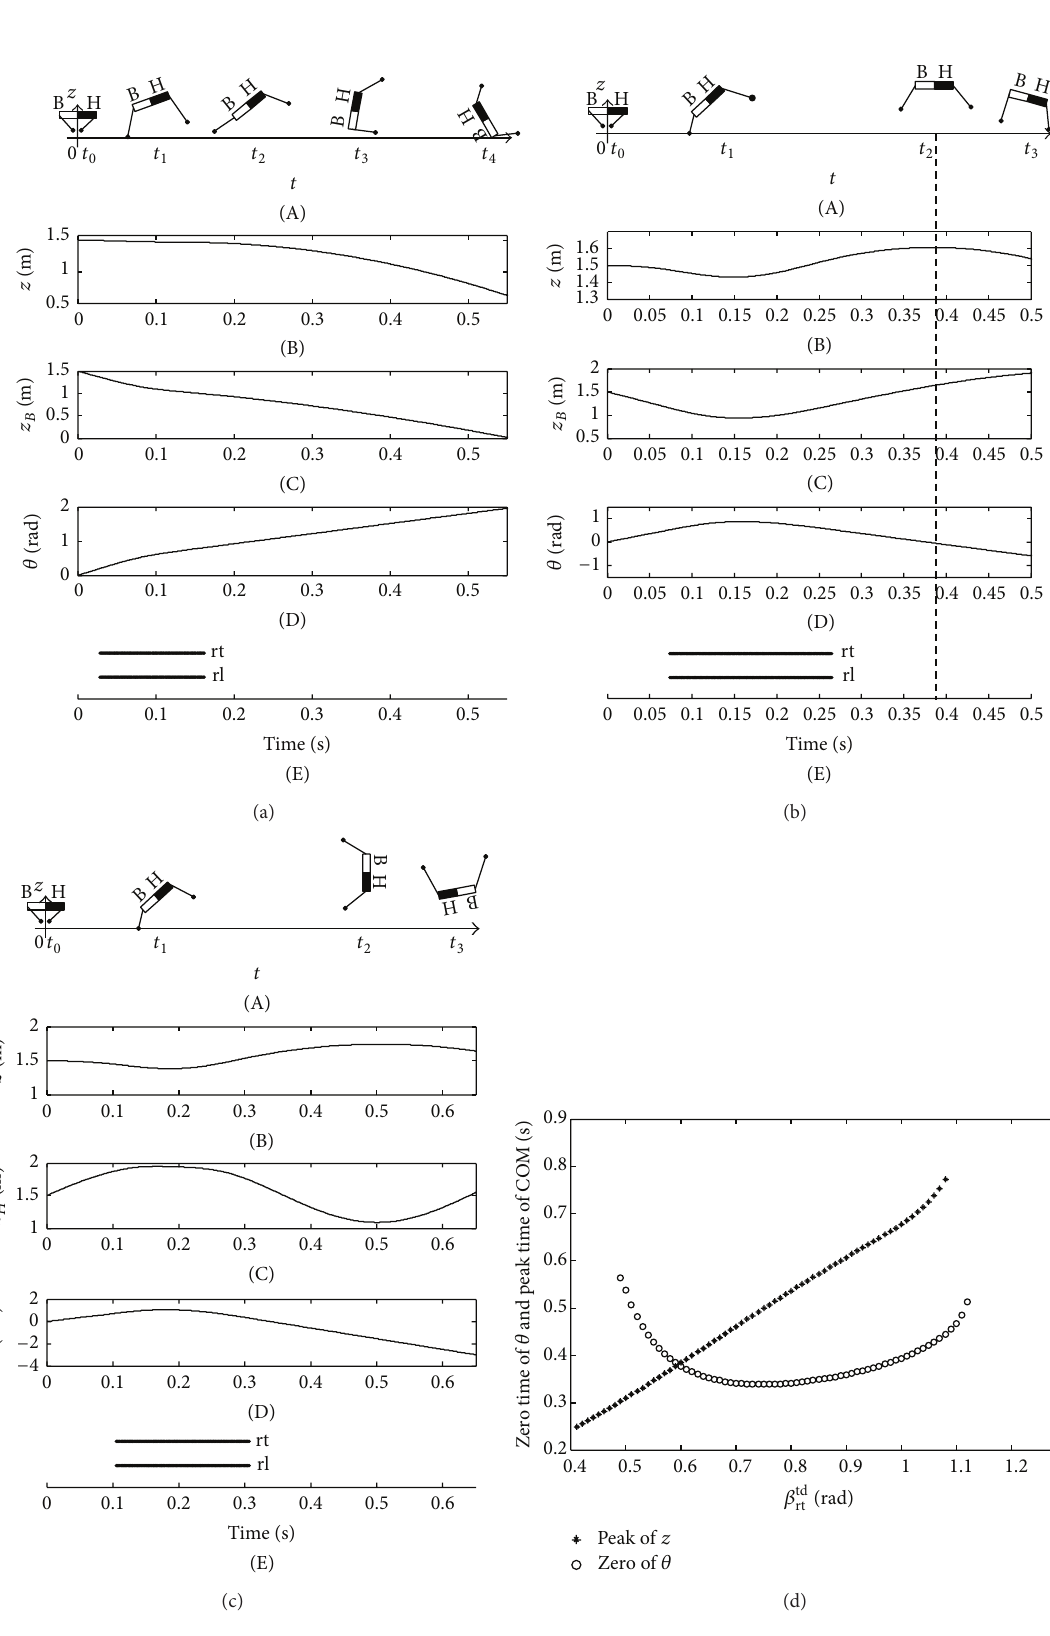
= 0 . 76 rad; (d) the zero time of pitching angle and the peak time of rt